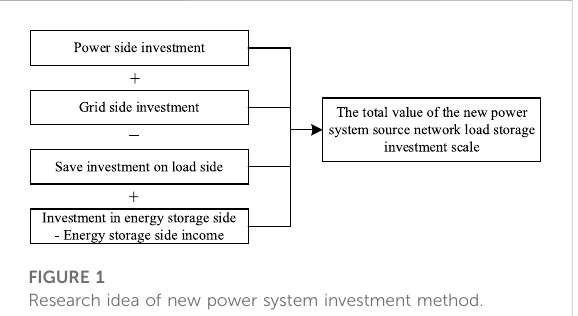
FIGURE 1 Research idea of new power system investment